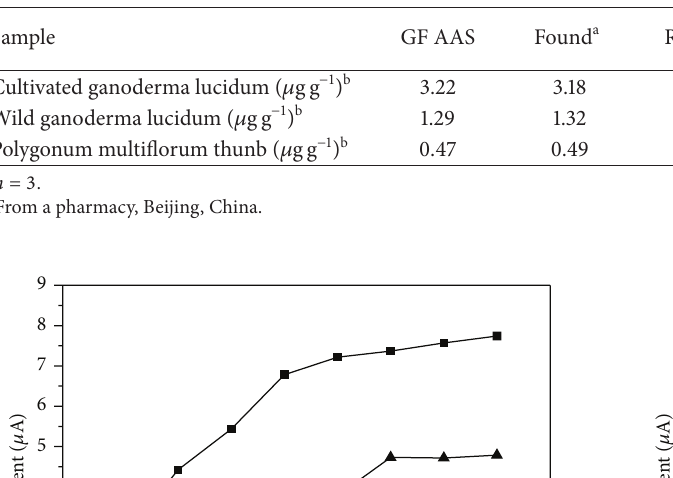
Table 1: Results for the determination of total germanium in several Chinese herbal remedies and the recovery rate. Sample GF AAS Found a RSD (%)